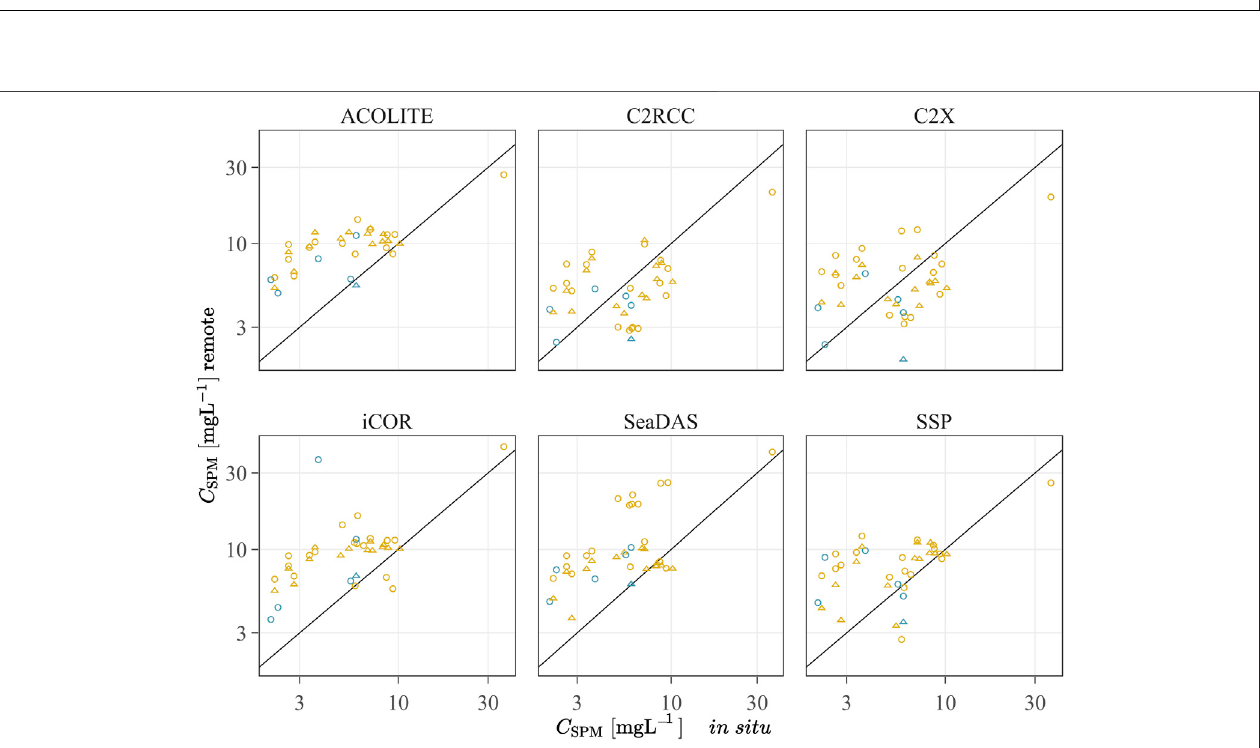
FIGURE11 | C SPM measured in situ vs. estimated remotely withthe red band empirical algorithmapplied toMSI (circle) and OLI (triangle) in theEGSL (orange) and JB (blue). The solid black line represents the 1:1 relation.